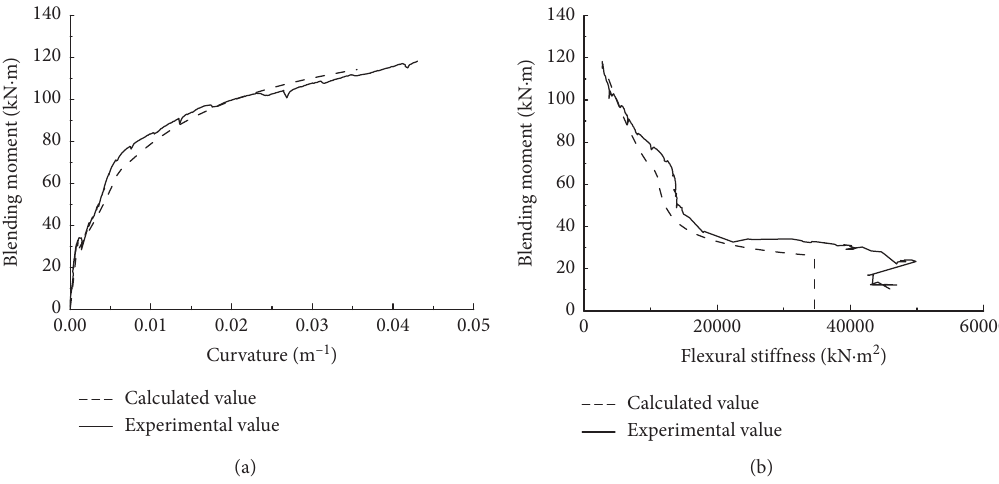
Figure 16: Beam B-2-30-4. (a) Bending moment-curvature curve. (b) Bending moment-stiffness